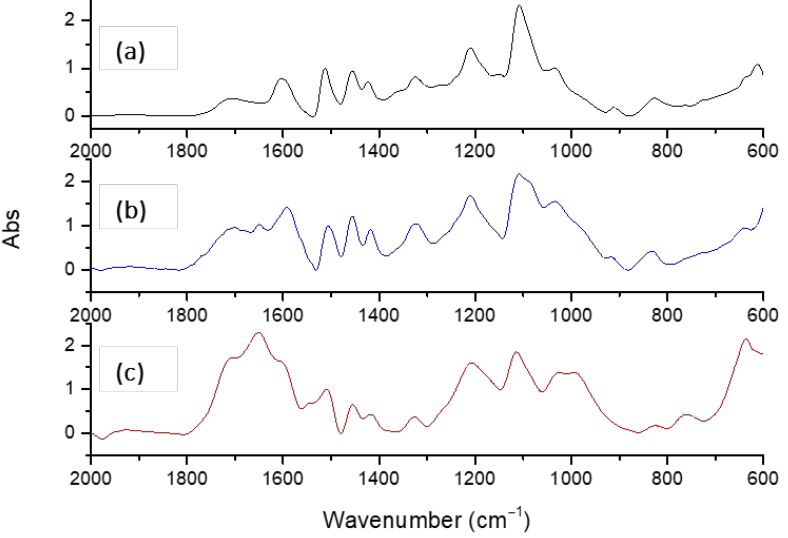
Figure 6. FTIR spectra, 2000–600 cm − 1 region of the untreated lignin (( a ), black line) and of the resulting treated lignins with MtL (( b ), blue line) and SiLA (( c ), red line) laccases. The bands in each spectrum are normalized with regard to the band at 1515 cm − 1 .